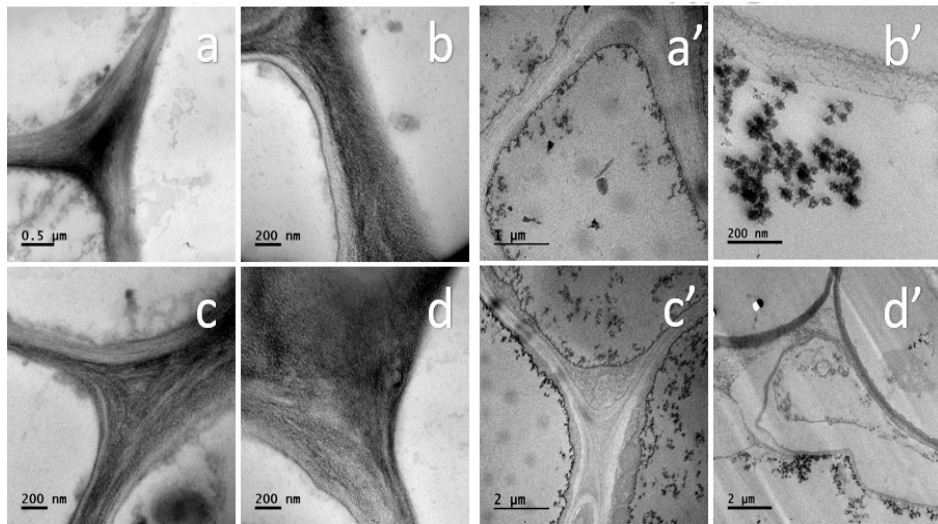
Figure 11. Ultrastructure of tomato root by TEM, with and without TiO 2 NPs. ( a – d ) cell walls without TiO 2 NPs. ( a ’– d ’) cell walls with TiO 2 NPs.